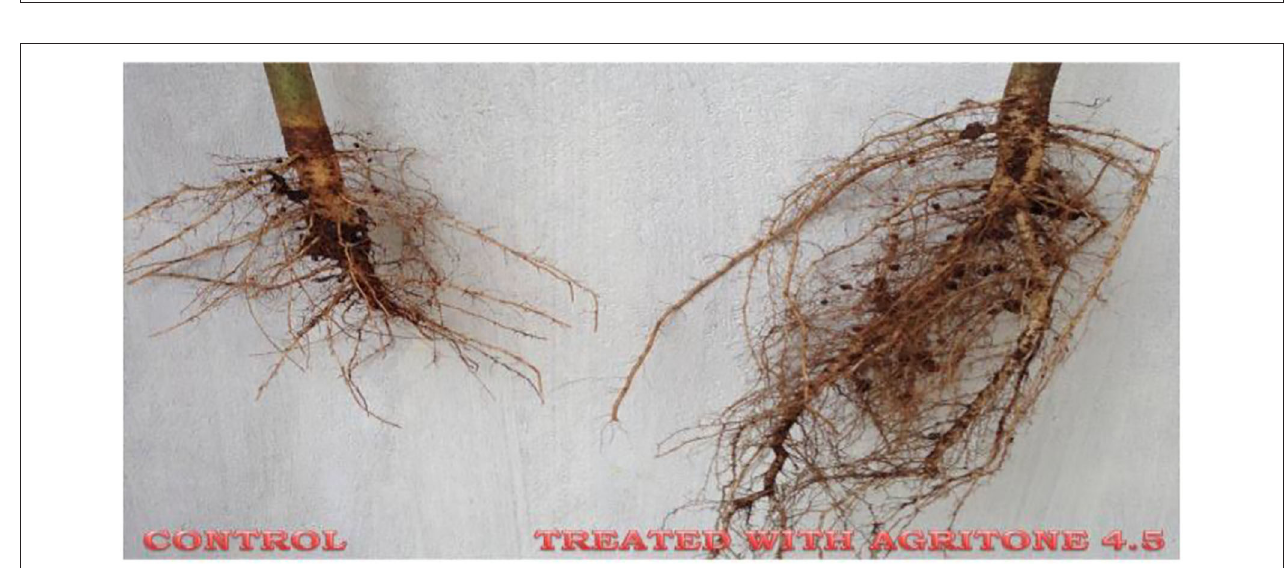
FIGURE 11 | Effect of humic acid preparation (Agritone 4.5) on root